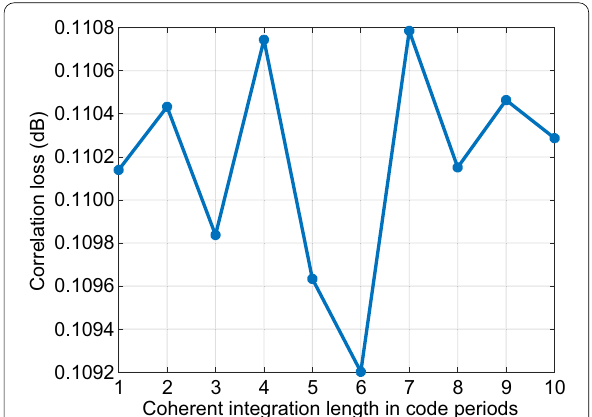
Fig. 12 Power spectrum of BDS-3 GEO-1 PPP-B2b